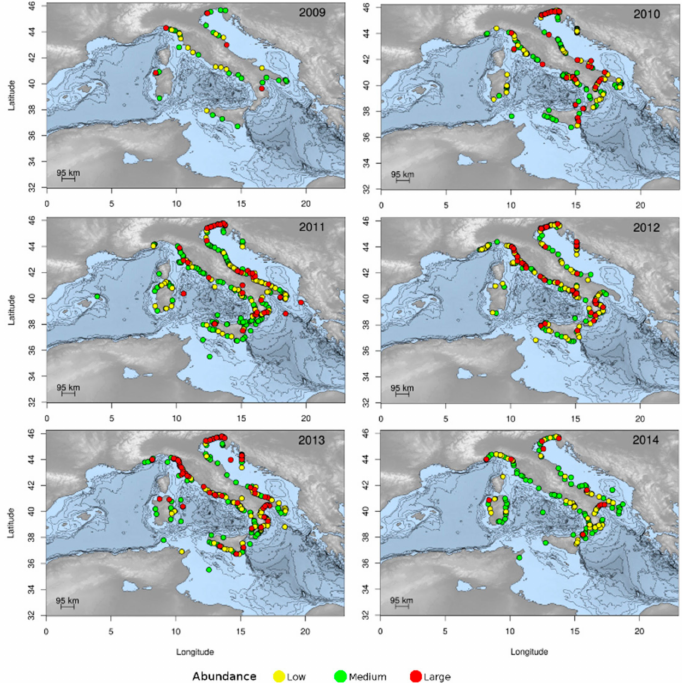
Figure 7. Spatial distribution of jellyfish reports from 2009 (upper-left panel) to 2014 (lower-right panel) for Rhizostoma pulmo in Italy (* see Section 2.1—Materials and Methods). Abundance categories are shown as follows: category 1—“low” in yellow, category 2—“medium” in green, and category 3—“high” in